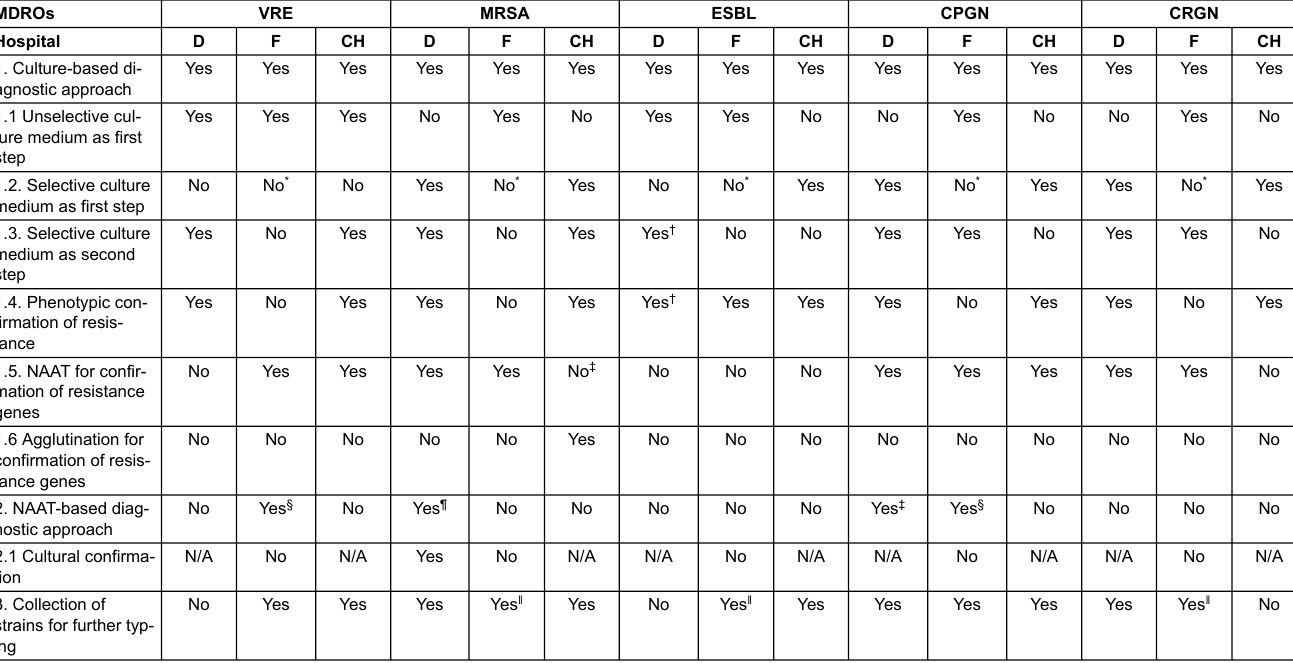
Table 2: Diagnostic measures for multidrug-resistant organisms (MDROs) in the Germany-France-Switzerland tristate area. MDROs VRE MRSA ESBL CPGN